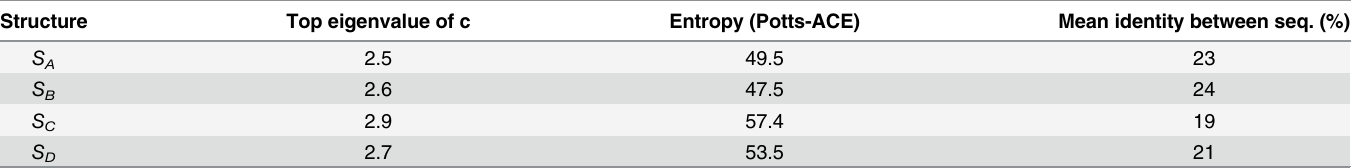
Table 1. Designabilities and entropies of structures S A to S D . Some estimates of how designable are the protein families associated to structures S A , S B , S C , S D : largest eigenvalue of the contact map matrix c (1st column) [25], entropy of the Potts-ACE model (2nd column), shown to be generative in Fig 3A, and mean percentage of identity between sequences in the attached multi-sequence alignments (MSA) (3rd column). The mean identity is defined as the number of sites carrying consensus amino acids, averaged over all sequences in the MSA and divided by the length of the protein ( L = 27); low identity corresponds to diverse MSA, and, hence, to large designability. According to our estimates of the entropies, the volumes (Fig 1) associated to structures S B and S C are, respectively, of about 410 20 and 8.510 24 sequences, while the total number of sequences is 20 27 ’ 10 35 . For more information about the meanings of desig- nability and entropy, see Section I.B in S1 Text. Structure